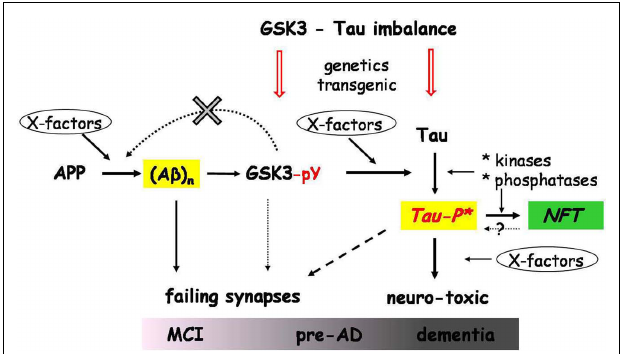
FIGURE 1 | Schematic relations between amyloid, GSK3, proteinTau, and other factors. The scheme depicts the activation by amyloid peptides of GSK3 α / β by increasing tyrosine phosphorylation, and leading to increased phosphorylation of proteinTau as the central event in AD pathogenesis. Condensed from in vivo observations in transgenic models, both proven (solid arrows) and proposed effects (broken arrows) are represented.The unknown molecular factors (X-factors) and mechanisms behind the relations and connections in this scheme are not yet fully understood as discussed in the text. Our most recent results did not confirm the proposed feedback effect of GSK3 on APP processing (data not shown).The amyloid and pTau species that cause synaptic defects, and eventually neurodegeneration, are not aggregates, but soluble oligomers (marked in yellow boxes).The phosphorylation ofTau by GSK3 and other kinases, produces a neurotoxic species, represented here asTau-P*.This hypothetical intermediate is a soluble single, dimer, or small aggregate, in a transitional conformational state that can be directed either into aggregation (NFT; green box) or toward synaptic and neuronal toxicity. Tau-P* causes synaptic dysfunction, which in various combinations with amyloid peptides and aberrant activated GSK3 results in various synaptic defects, initiated in the earliest phases MCI or pre-AD, and evolving to dementia, as highlighted in the scheme.The genetic imbalance between GSK3 andTau genes depicted in the scheme refers to the proposed interaction between theTau (MAPT) and GSK3 β genes in humans, discussed in the text.This interaction might impact on both GSK3 activation or availability and theTau3R/4R ratio, thereby also contributing to the propensity ofTau phosphorylation.The imbalance is also generated in the various single and bigenic models, discussed in the text.The combination of all actors and factors and their interactions lead to a variety of clinical and pathological symptoms, observed in sporadic AD